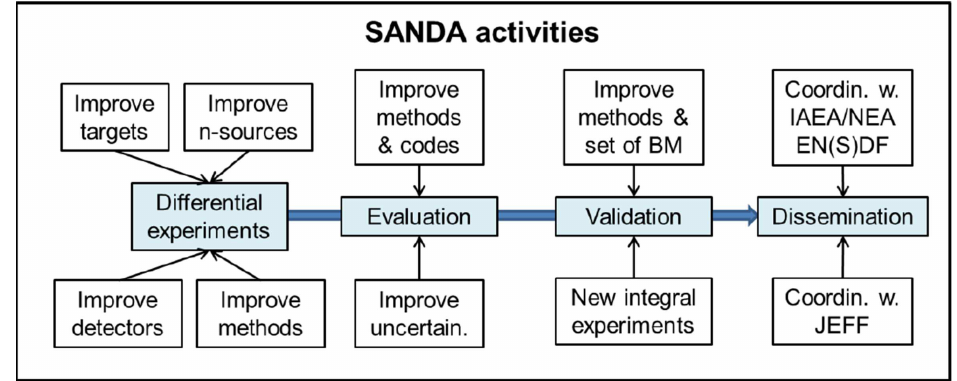
Fig. 2. SANDA activities and objectives on the full nuclear data